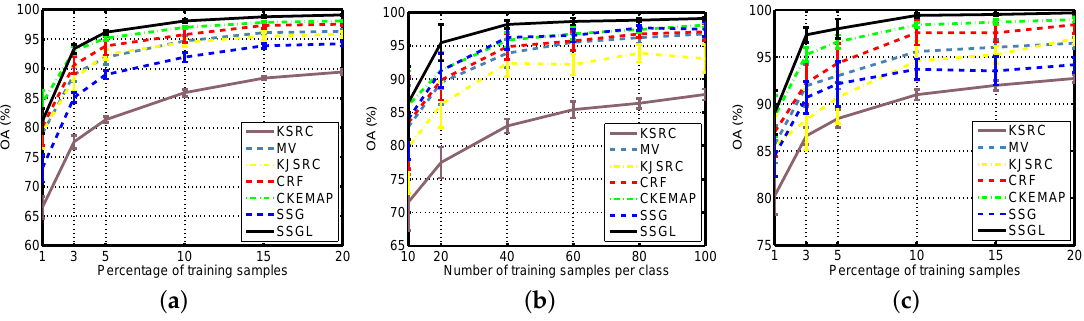
Figure 10. OA as a function of the number of training samples for different classification methods when applied to ( a ) the AVIRIS Indian Pines dataset, ( b ) the ROSIS University of Pavia data set, and ( c ) the AVIRIS Kennedy Space Center